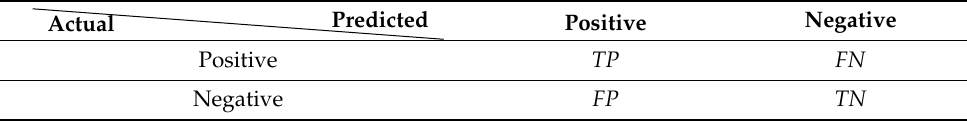
Table 4. An example of a confusion matrix. Actual Predicted Positive